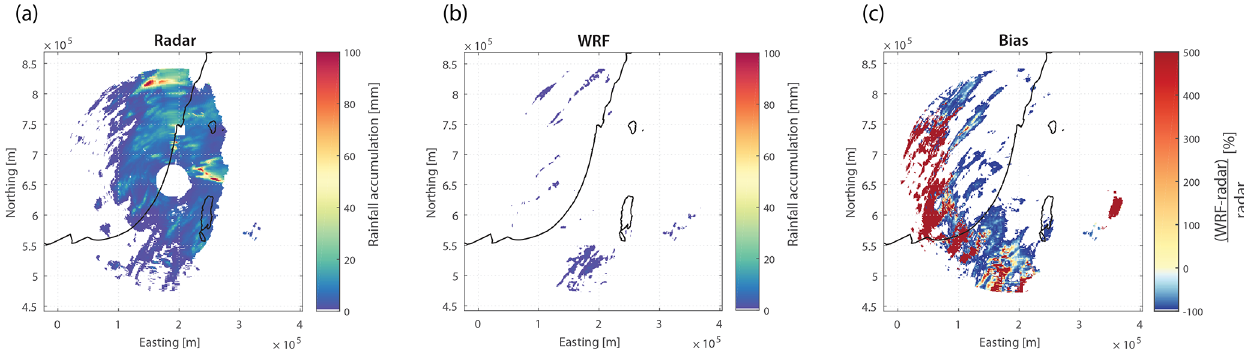
Figure 8. Same as Fig. 7a–c but for HPE 5 (09:00LT, 31 March 1993 to 02:00LT, 2 April 1993; Table